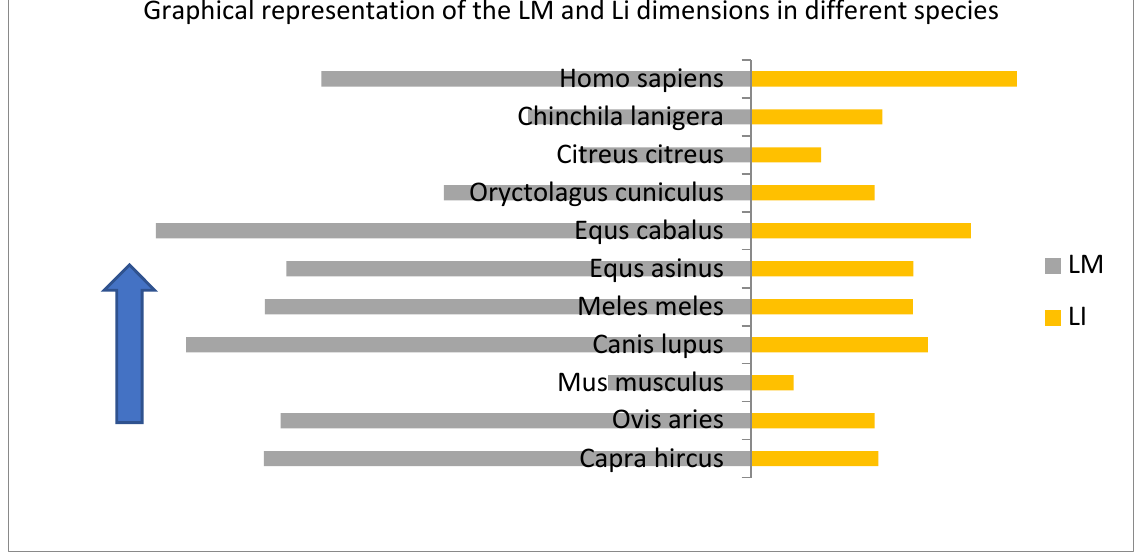
Figure 9. Representation of the malleus:incus proportions (ascending).